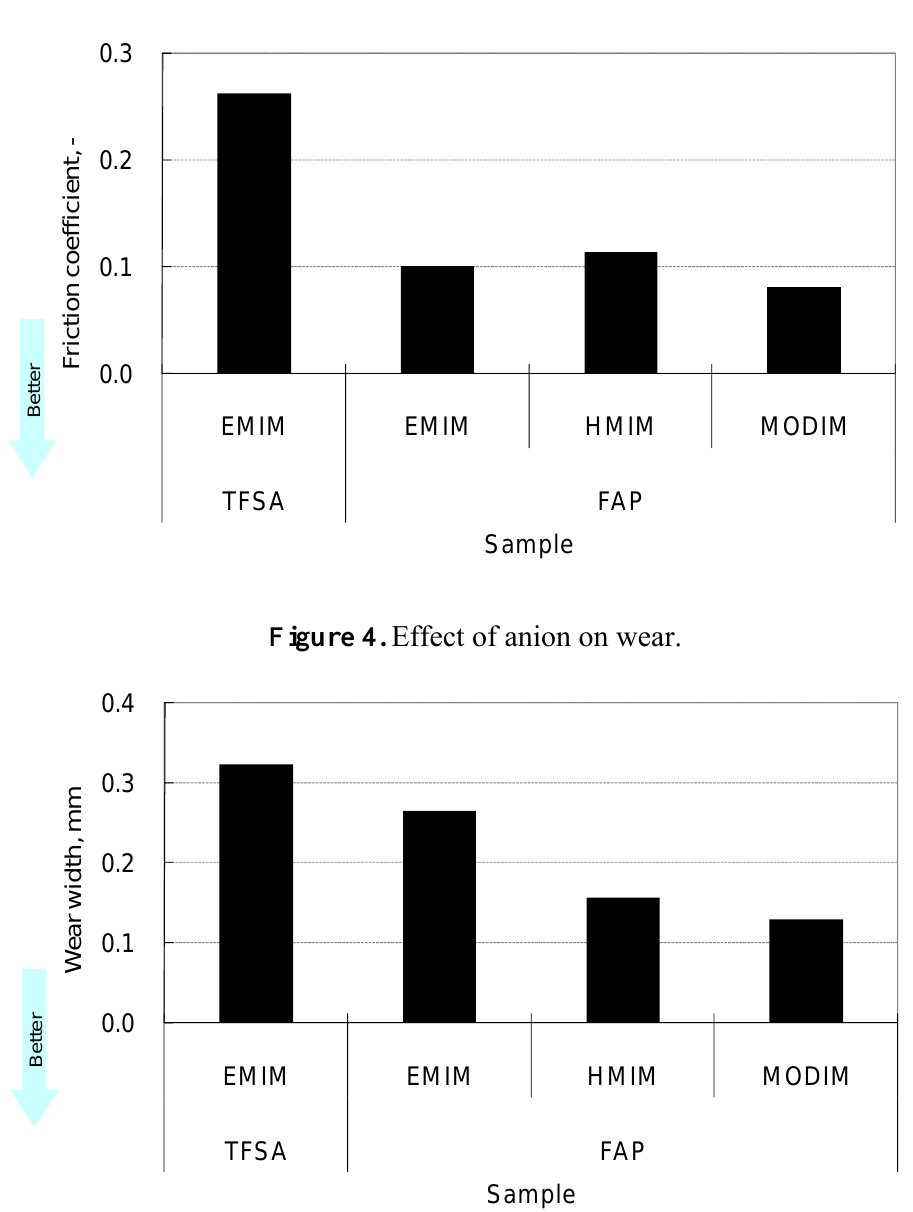
Figure 3. Effect of anion on friction.